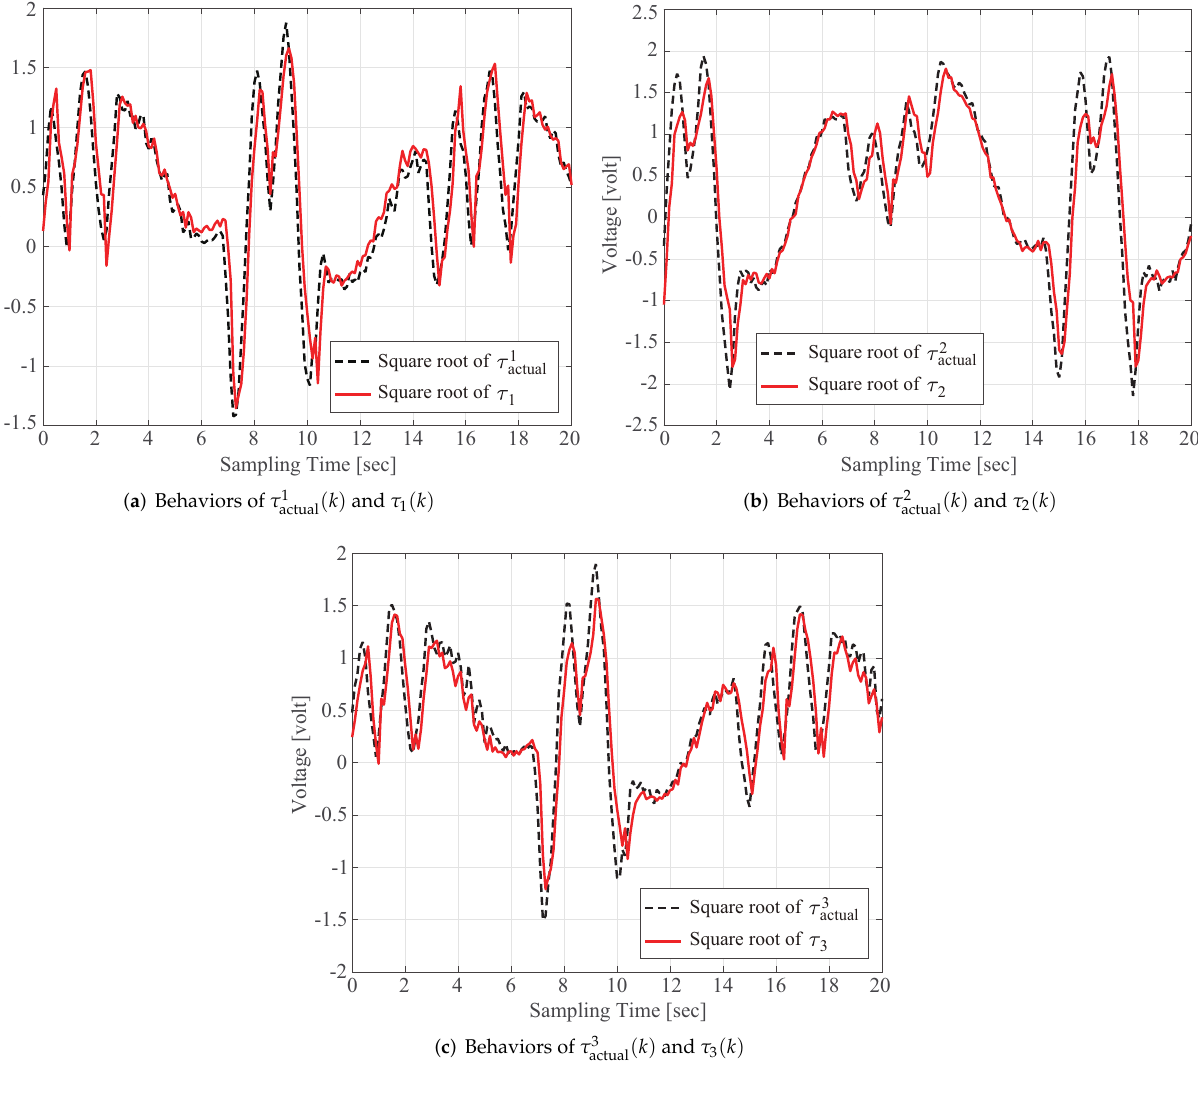
Figure 6. Comparison of the measured actual torque τ actual and the torque τ computed using (26) with the identified parameter values in